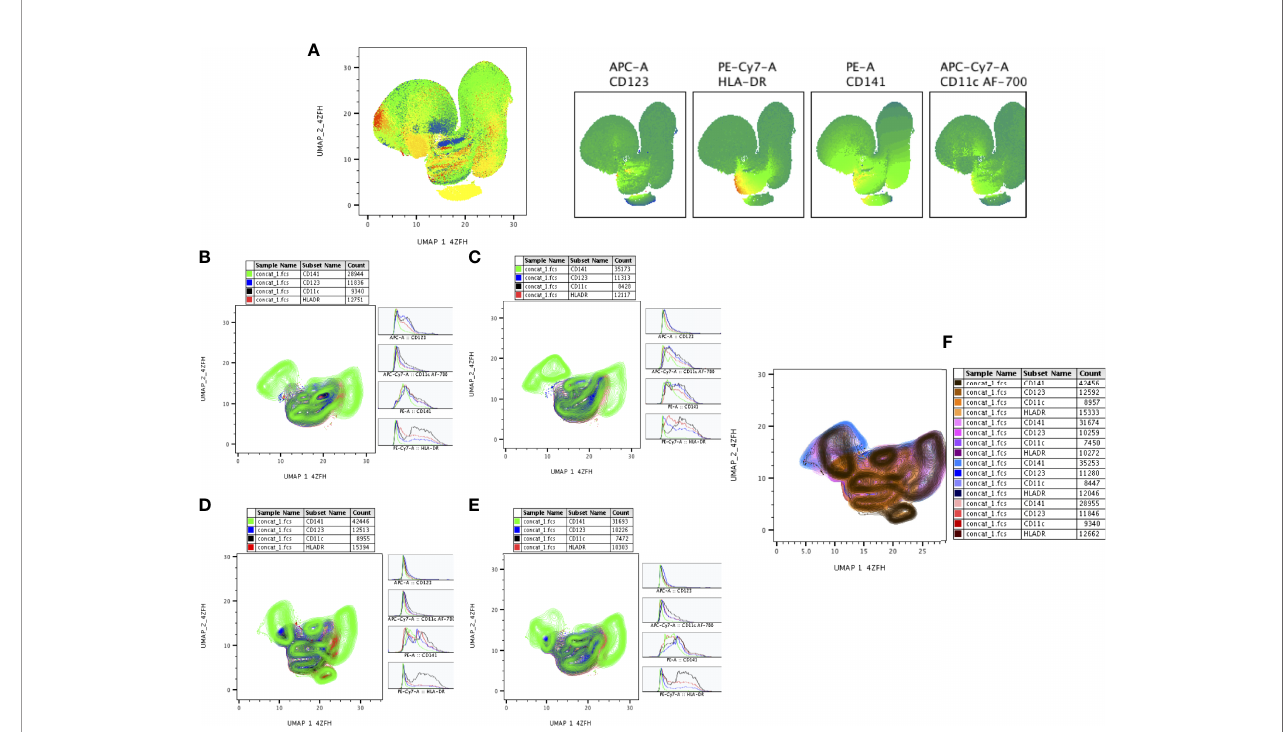
FIGURE 7 | UMAP analysis of DC subsets. HLADR + (10,000 cells) were down sampled for monocytes/granulocytes and performed (A) unsupervised (UMAP (UMAP_1_4ZFH vs UMAP_2_4ZFH) clusters (ungated) and expression of individual DC (CD123, HLADR, CD141, CD11c) markers between the study (DR-TB, DS- TB, LTB, HC) population. (B – E) shows the DR-TB, DS-TB, LTB and HC group expression of DC marker (islands) subsets using contour plots. (F) shows merged contour plot expression of DC subsets among the study